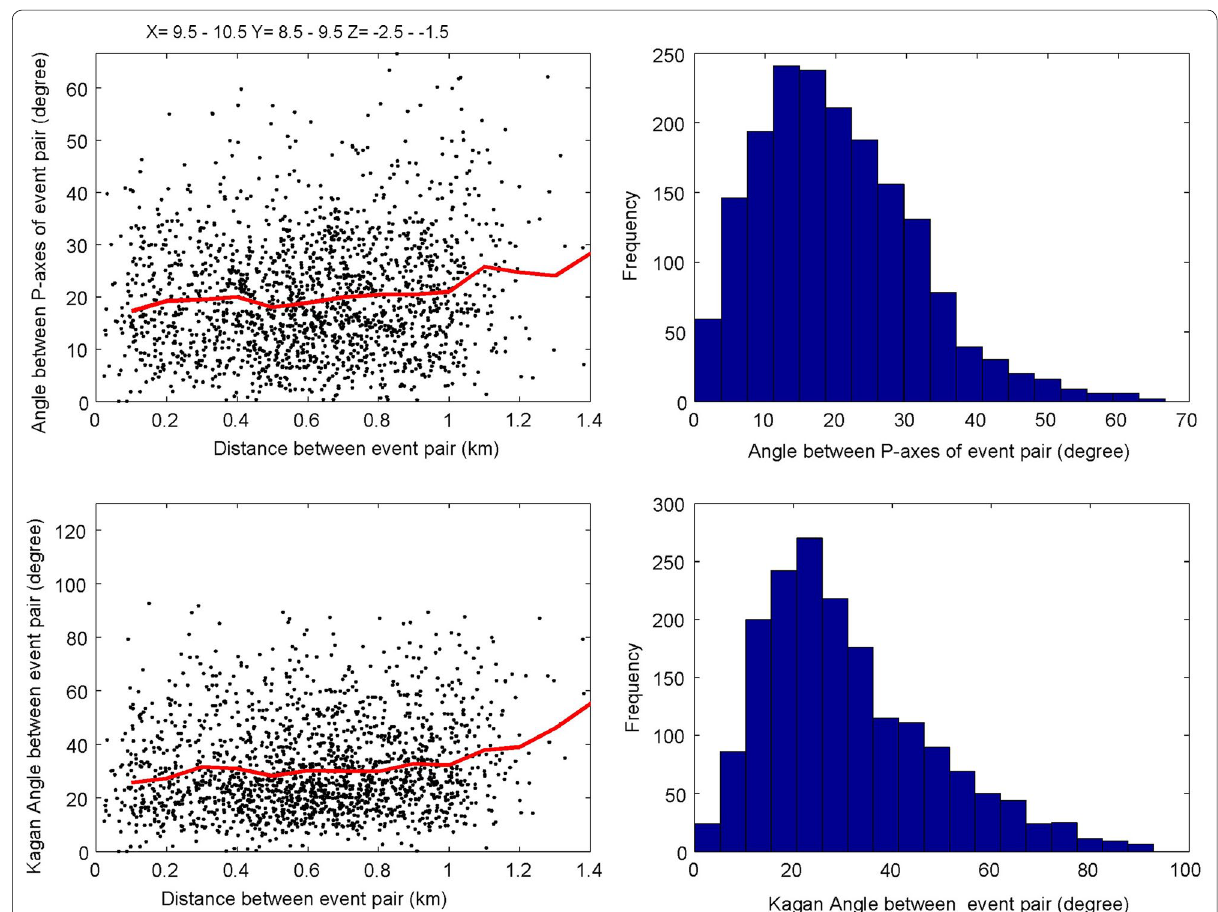
Fig. 13 (Upper) Relationship between focal distance and the difference in P -axis orientations (the angle between two P -axes) for each event pair in the cubic subregion for a grid point ( x 10, y 9, z 2), and the frequency distribution of angles between two P -axes of each event pair. = = = − (Lower) Similar plots for Kagan angles between focal mechanisms of each event